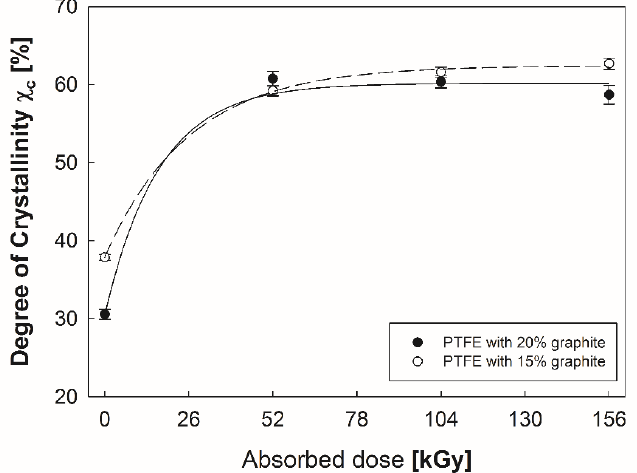
Figure 3. Changes in the average molecular weight of PTFE with different graphite additions.